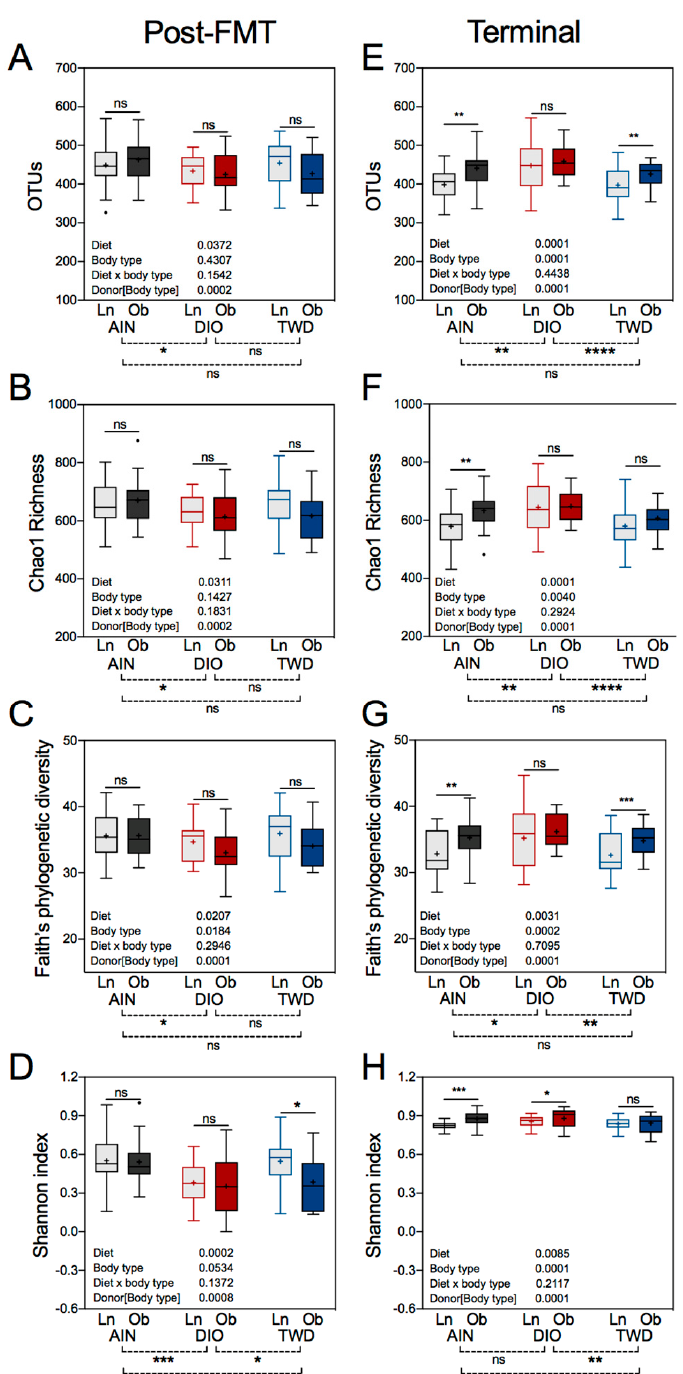
Figure 11. Alpha diversity of recipient microbiomes post-FMT and at necropsy. Operational taxonomical units (OTUs) ( A , E ), Chao1 richness ( B , F ), Faith’s phylogenetic diversity ( C , G ), and Shannon index ( D , H ) alpha diversity measures for fecal mouse microbiomes post-FMT and at necropsy are presented as Tukey box plots (box, 25th to 75th percentiles; whiskers, 1.5 IQR; +, mean) ( n = 6 to 9). The tables within each panel show p -values for the main effects of each experimental factor as determined by the mixed model analysis. Below each plot, brackets indicate the results of Tukey post hoc tests for the overall effects of each diet. Within each diet group, symbols above the box and whisker bars indicate the results of post hoc tests comparing mice that received bacteria from lean (Ln) or obese (Ob) human donors. * p < 0.05, ** p < 0.01, *** p < 0.001, **** p < 0.0001, ns = not significant.